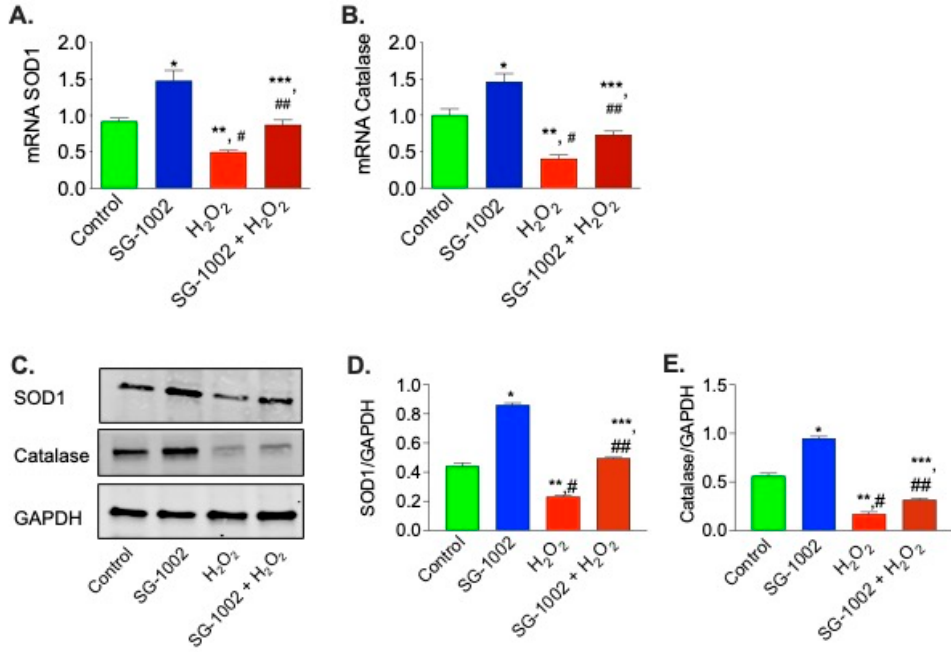
Figure 4. Effects of SG-1002 on mRNA and proteins levels of SOD1 and catalase in HL-1 cells. cDNA was prepared from RNA obtained from treated HL-1 cells followed by analysis of mRNA of SOD1 ( A ) and catalase ( B ) using TaqMan PCR assay system. SOD1 and catalase levels were determined in the protein extracts obtained from treated HL-1 cells by using immunoblot analysis. ( C ) represents blots for SOD1, catalase and GAPDH, ( D , E ) represent the quantitation of blots in ( C ). * and **, p < 0.05 vs. control; #, p<0.05 SG-1002 vs H 2 O 2 ; ##, p < 0.05 H 2 O 2 vs. SG-1002 + H 2 O 2 ; ***, p < 0.05 SG 1002 vs. SG 1002 + H 2 O 2 (Anova), (n = 4).